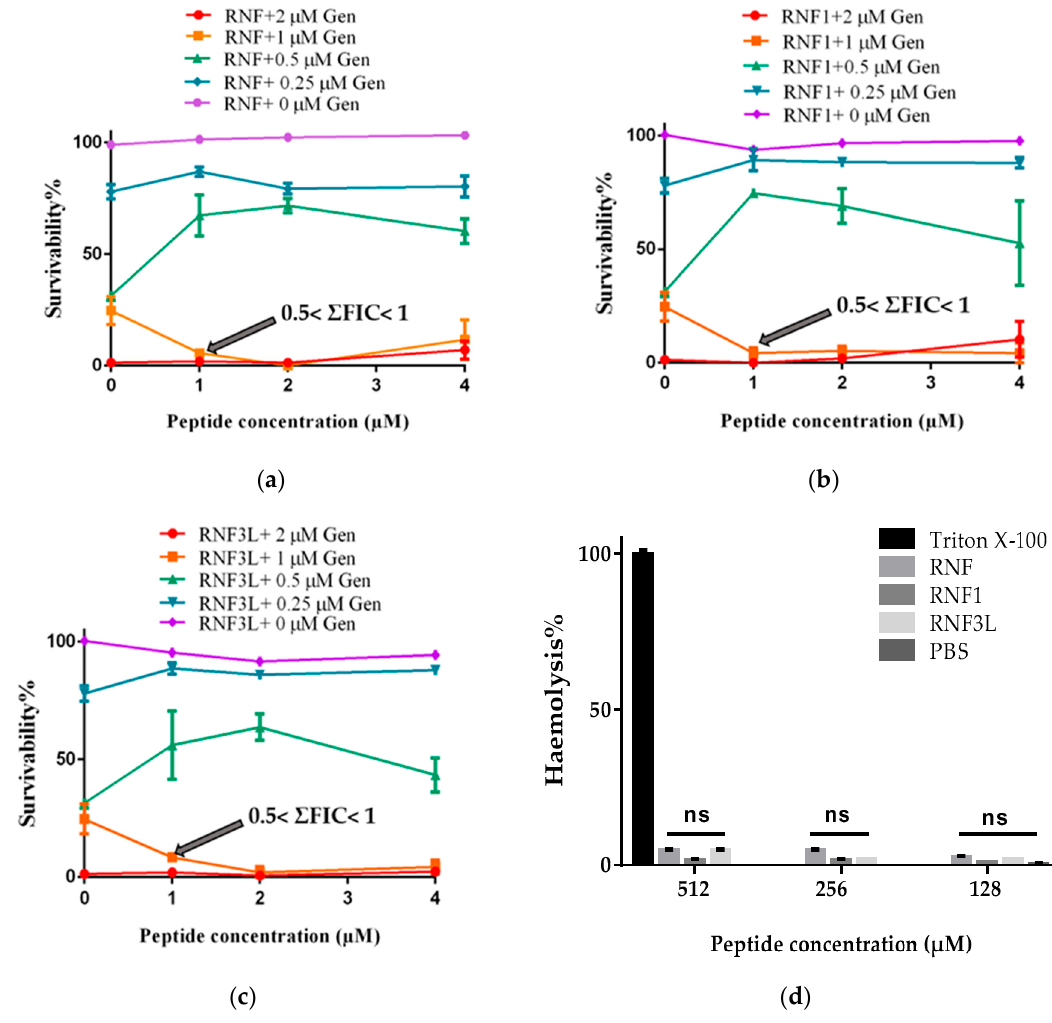
Figure 5. The additive effect against the growth of MRSA between Gentamicin (Gen) and: ( a ) RNF; ( b )